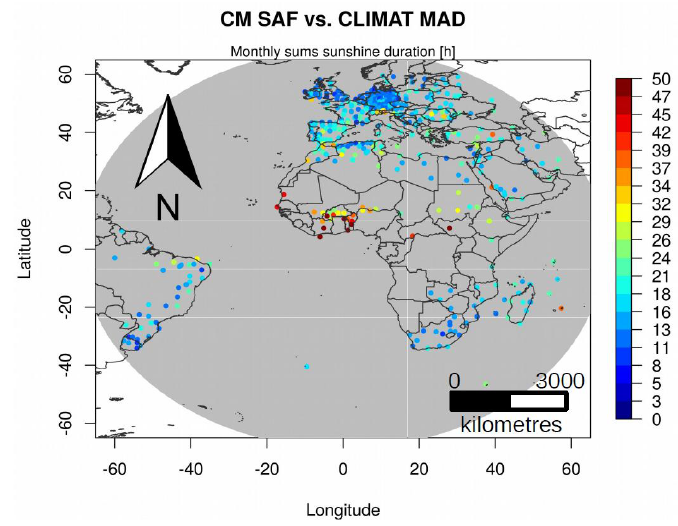
Figure 6. Spatial distribution of the MAD (h) between monthly SDU and CLIMAT for the time period 1983 to 2015.